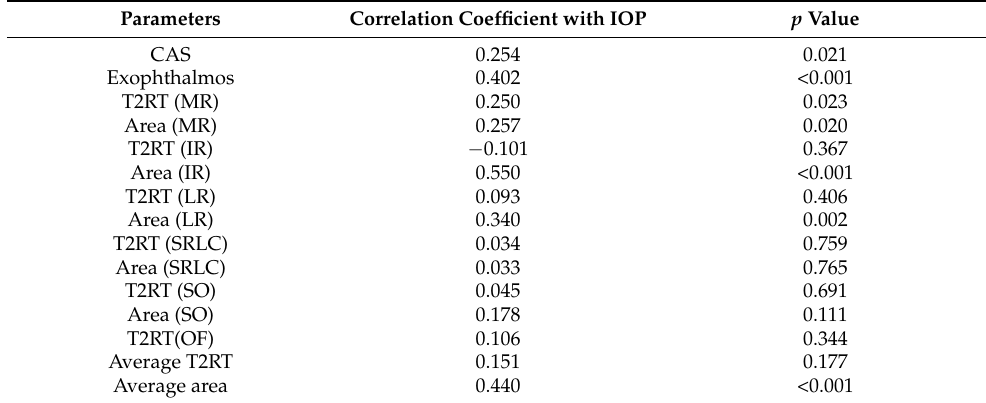
Table 3. Correlation analysis between IOP and CAS, exophthalmos and OMR parameters.